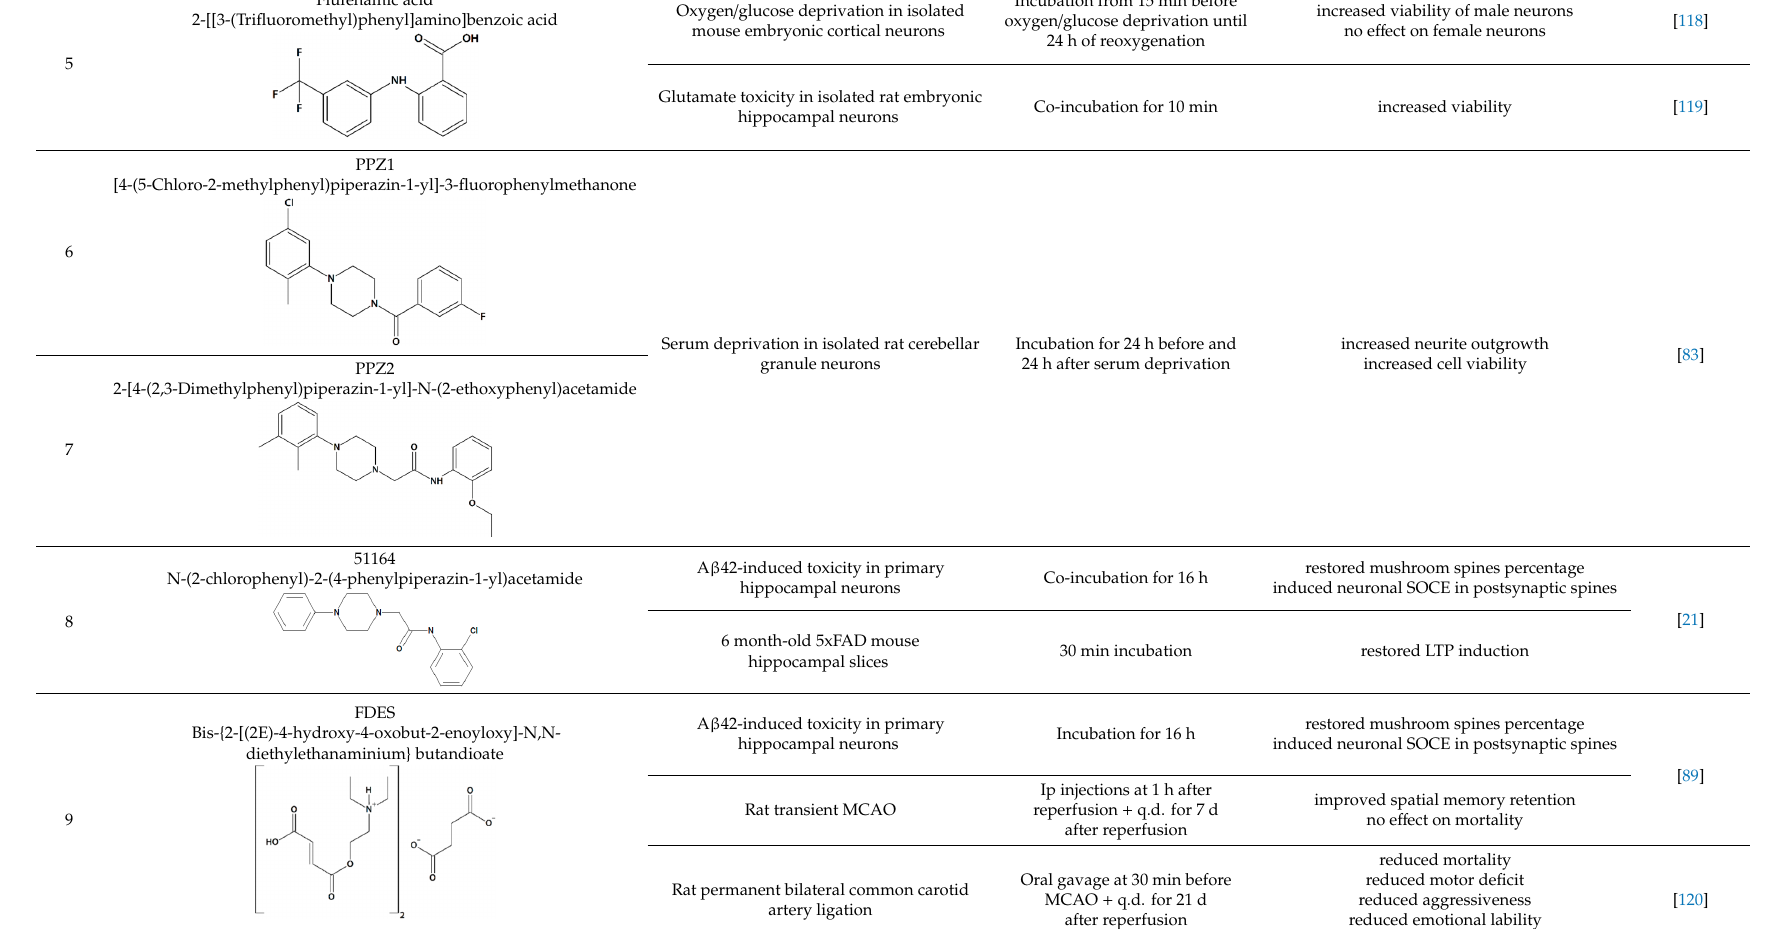
restored mushroom spines percentage induced neuronal SOCE in postsynaptic